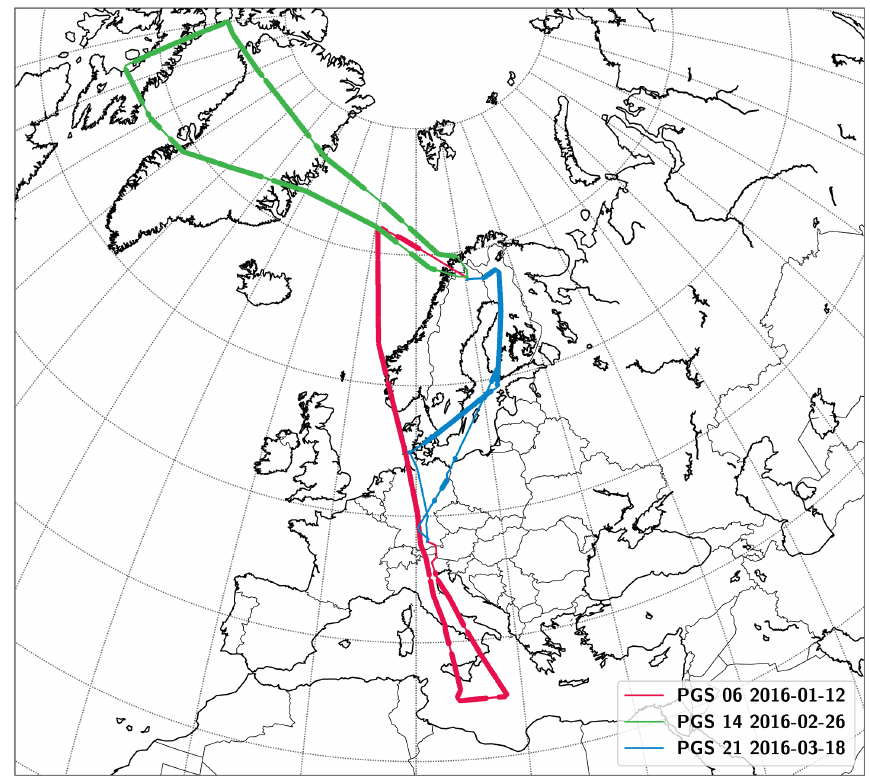
Figure 1. Flight paths of flights PGS06 (12 January 2016), PGS14 (26 February 2016), and PGS21 (18 March 2016) on which GLORIA measurements were performed and discussed in this paper. Aircraft positions with measurements in GLORIA high spectral resolution mode are marked as bold lines. The underlain map (bold black lines show coastal lines, regular black lines country borders, and dotted lines indicate a latitude by longitude grid) shows the European continent and is centered at 60 ◦ N latitude and 10 ◦ E